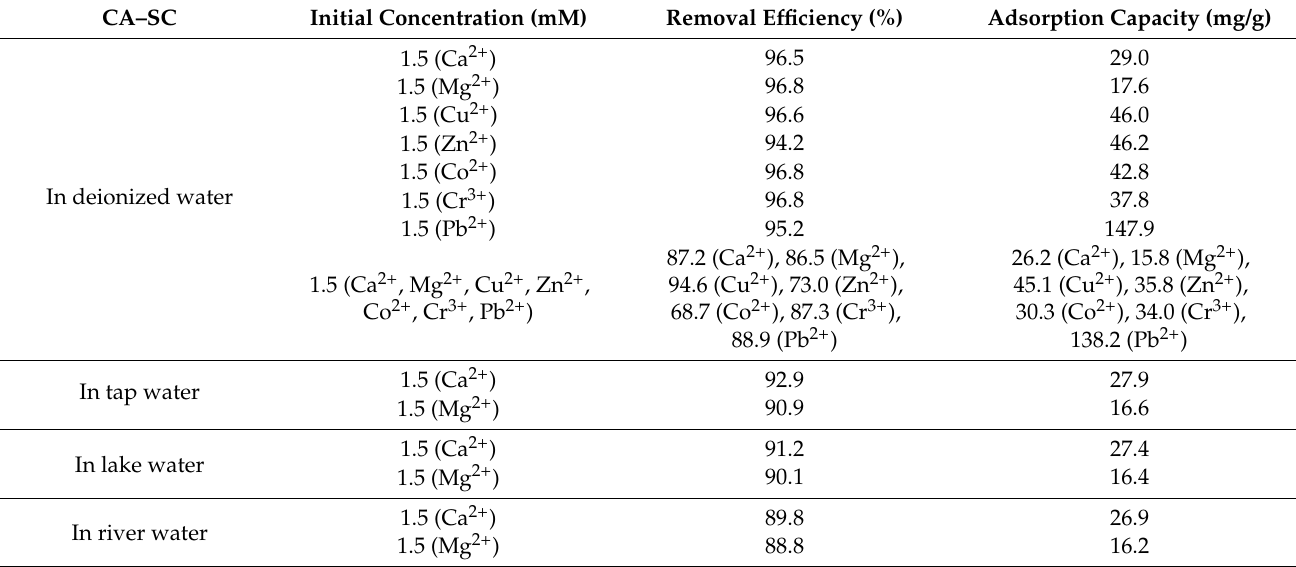
Table 2. Adsorption ability of CA–SC for different metal